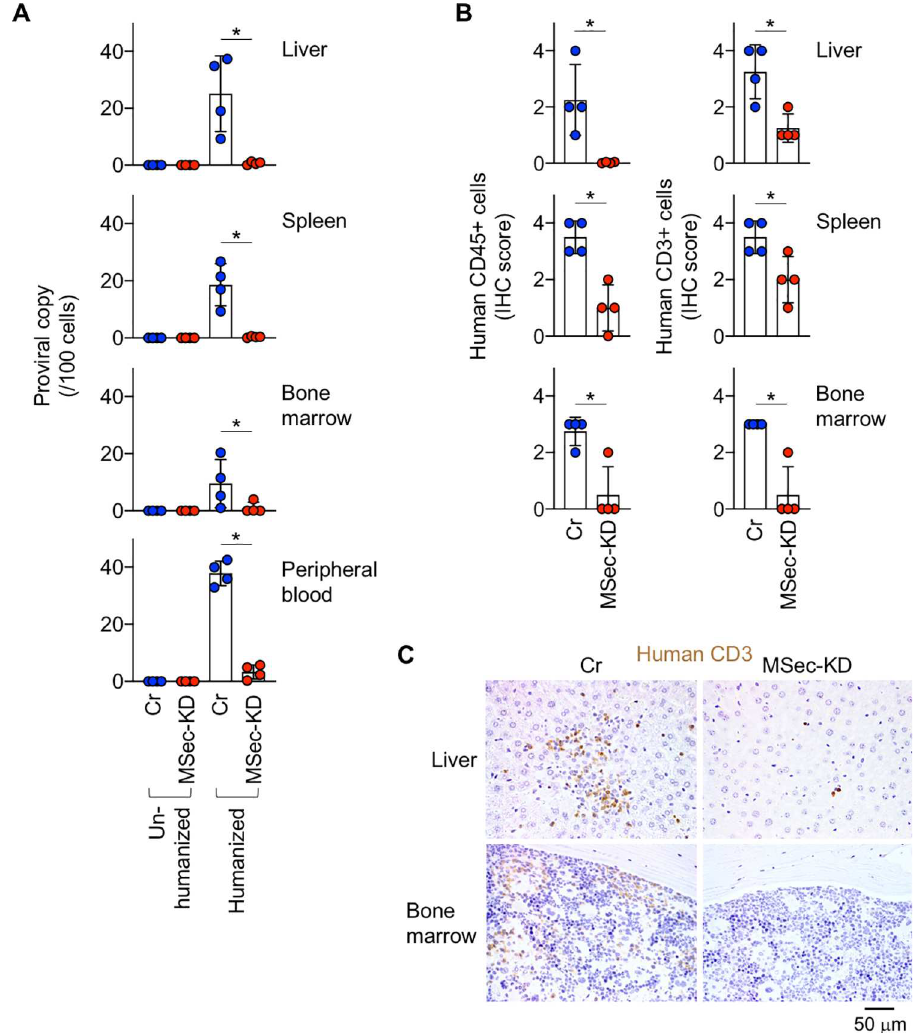
Fig 6. Effect of M-Sec knockdown on viral infection in a mouse model. ( A ) The un-humanized or humanized mice were inoculated intraperitoneally with irradiated control (Cr)- or M-Sec knockdown (MSec-KD) MT-2 cells. After 4 weeks, the cells in the liver, spleen, bone marrow, or peripheral blood were analyzed for proviral copies by qPCR (n = 4 for each group). The numbers of proviral copies per 100 cells are shown. � p < 0.05. ( B , C ) The humanized mice were inoculated with irradiated MT-2 cells as in ( A ). After 4 weeks, the liver, spleen, or bone marrow was analyzed for human CD45 + or human CD3 + cells by immunohistochemistry (IHC). In ( B ), semi-quantitative scores are shown (n = 4 for each group). � p < 0.05. In ( C ), typical images of human CD3 + cells (brown) in the liver or bone marrow are shown. Scale bar: 50 μ